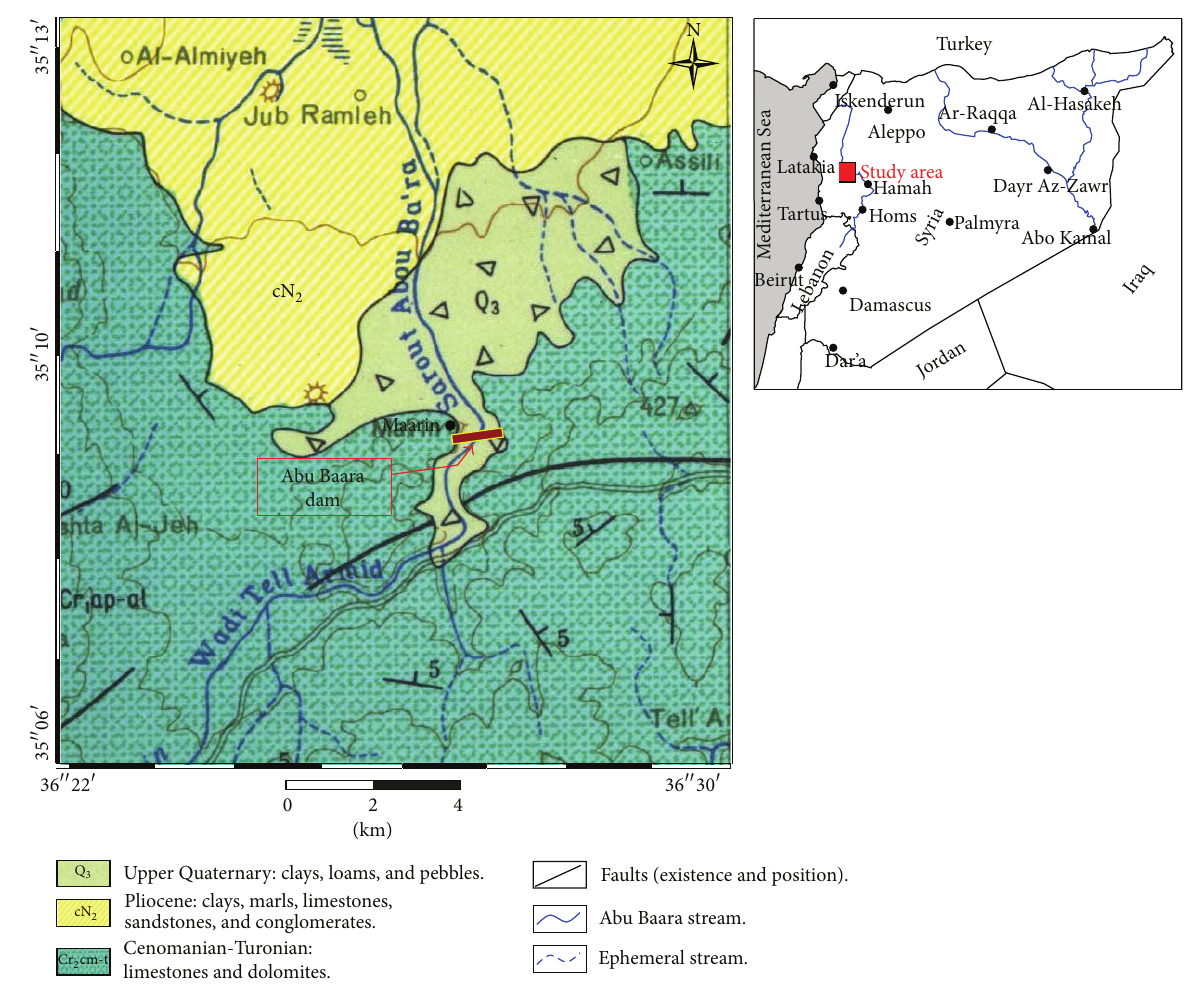
Figure 1: Geological map of the study area showing the location of Abu Baara dam, modified from [19].